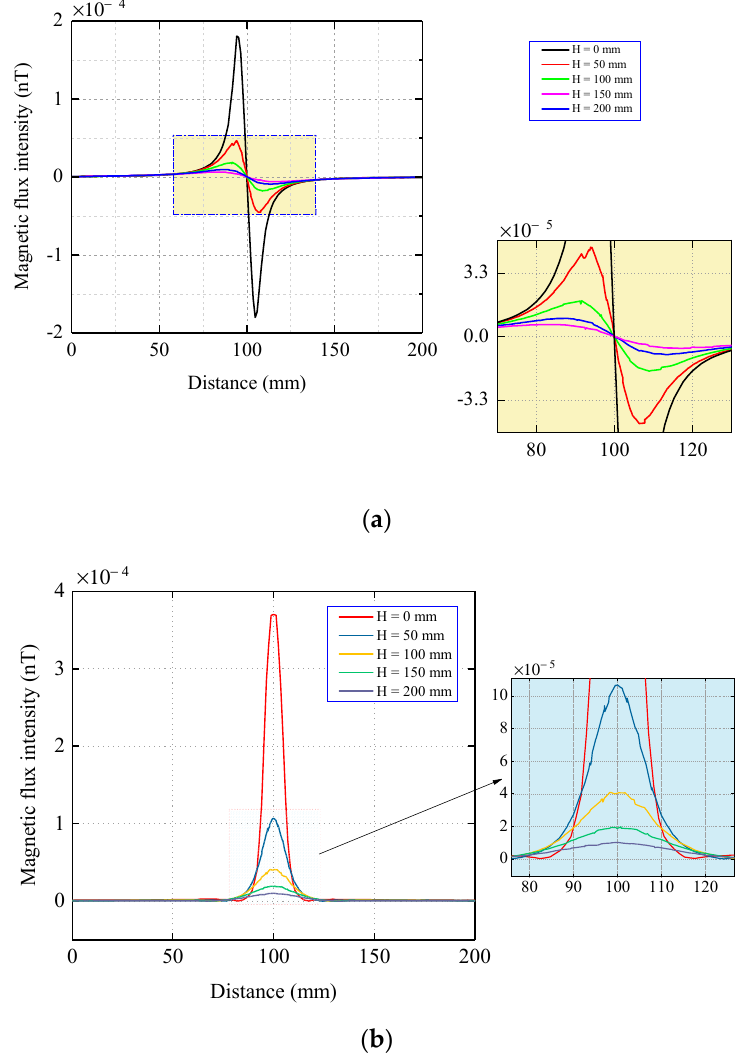
Figure 6. Distribution of the magnetic flux intensity when the stress concentration zone is located on the top of the inner wall of the pipe. ( a ) Tangential component. ( b ) Normal component.